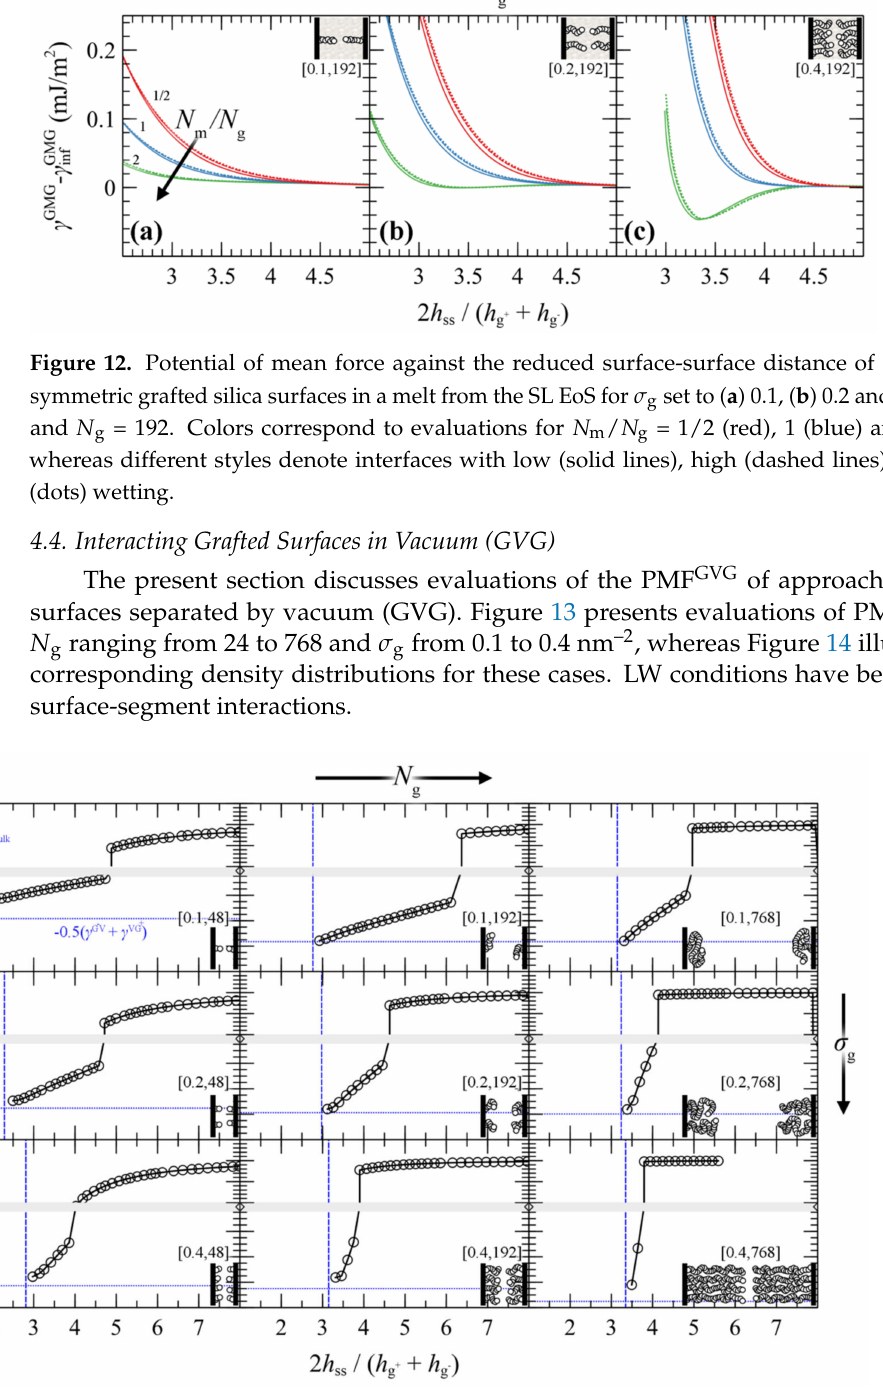
Figure 13. Potential of mean force for approaching grafted surfaces in vacuum (GVG) with the SL-SGT EoS. Values of σ g (nm − 2 ) and N g are indicated in brackets. Horizontal blue lines mark minus the average surface free energy of the individual grafted films. Vertical blue lines mark the thickness h ss , that would correspond to the total mass of grafted polymer at bulk density. Insets: each bead denotes a segment of 24 PS monomers. Bands denote scale changes along the